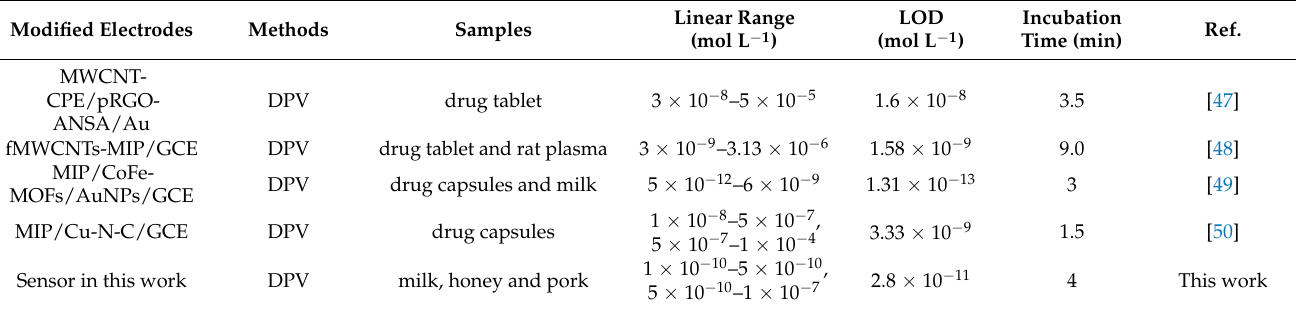
Table 4. Linear range and LOD of MIP/TBC/GCE compared with other previously reported